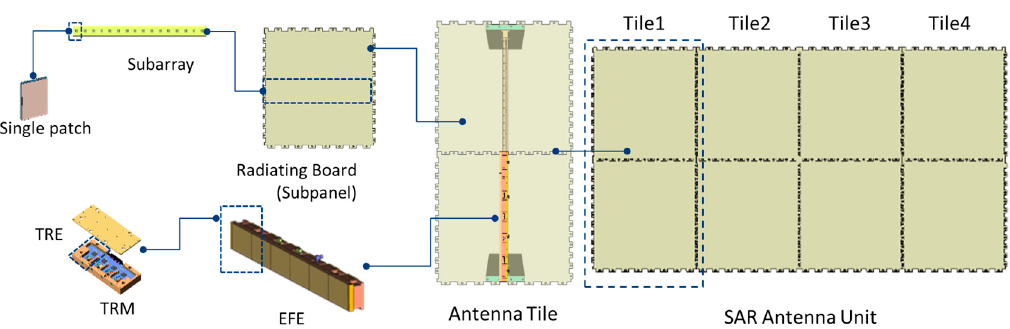
Figure 10. Mechanical structure of the tile-based S-STEP SAR antenna unit (SAU).